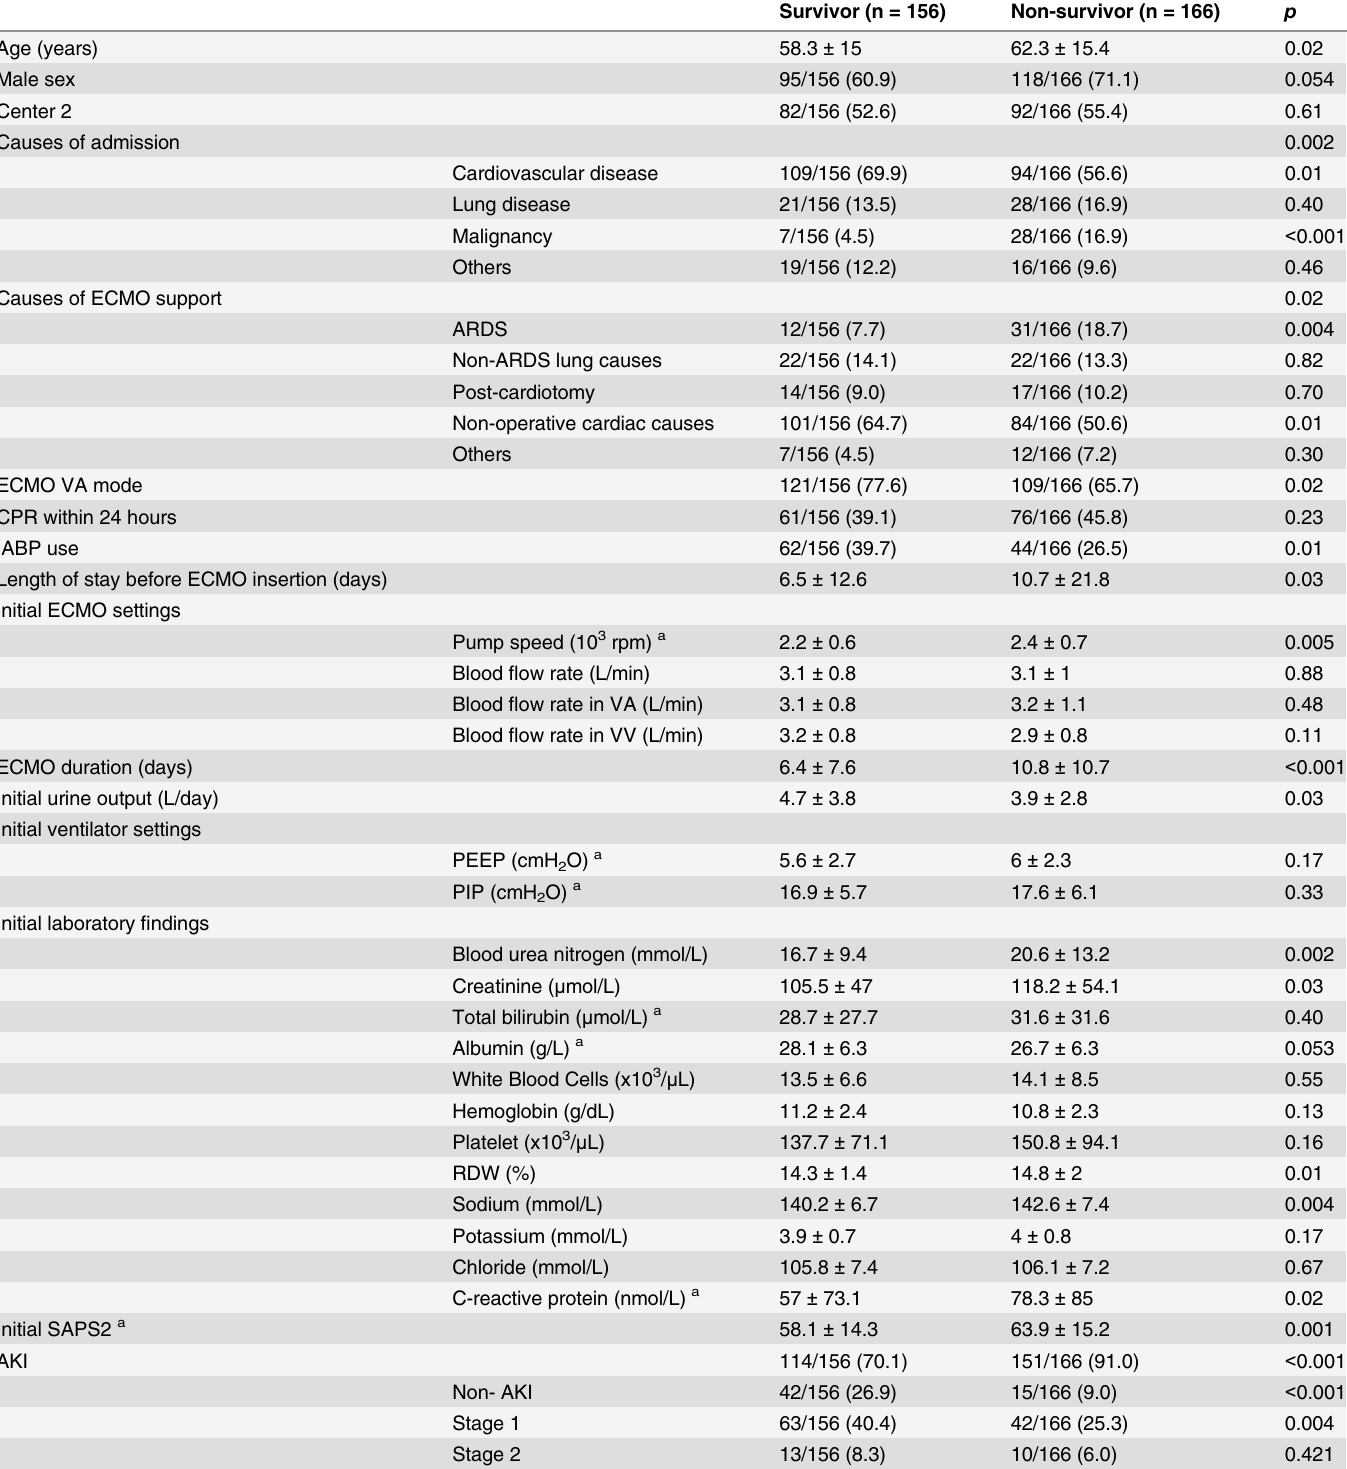
Table 1. Patient characteristics according to survival